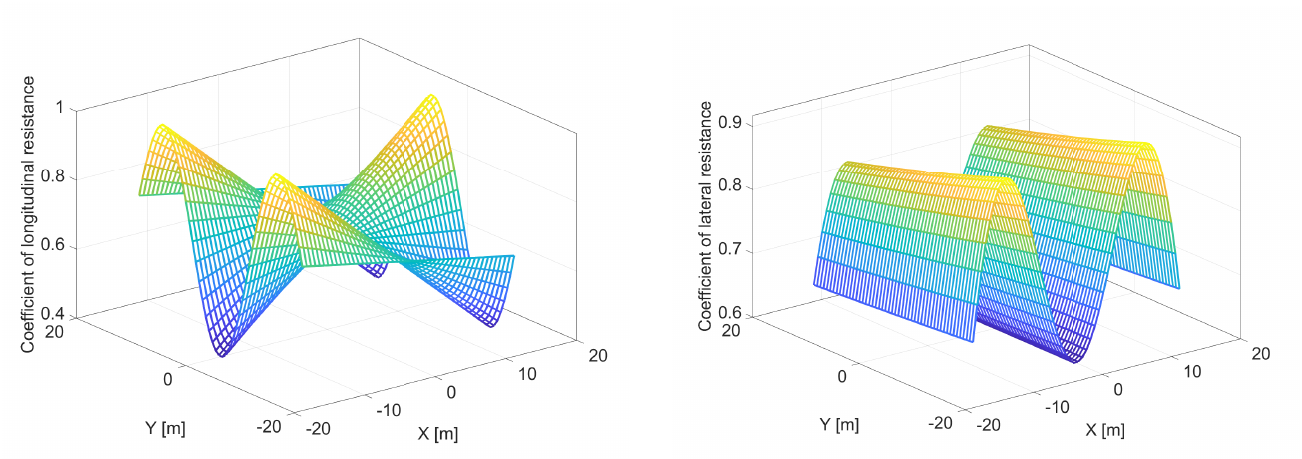
Figure 18. Maps of resistance coefficients: longitudinal ( left ) and lateral ( right ).